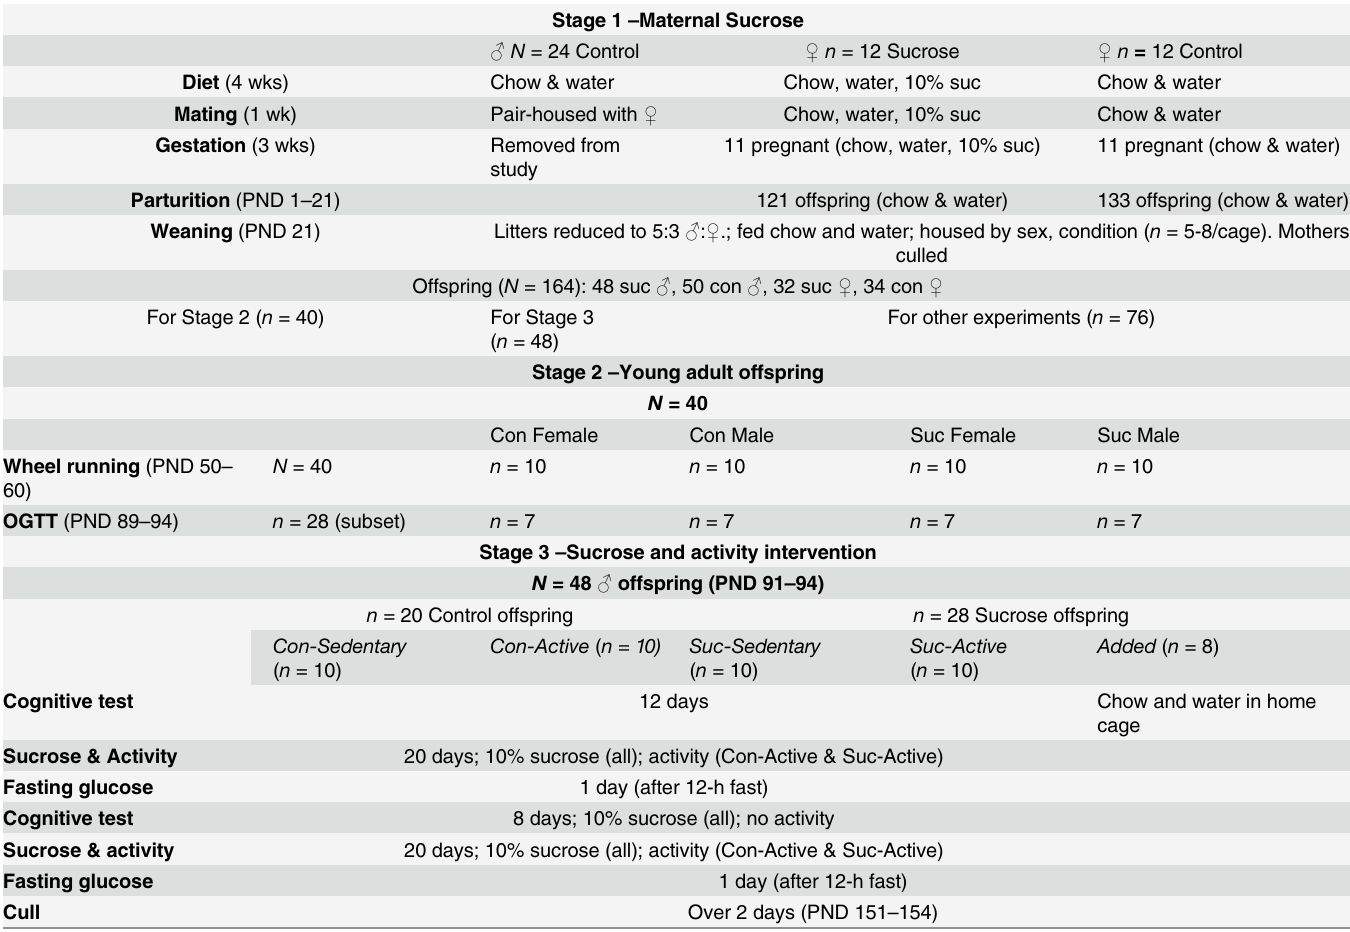
Table 1. Timeline of experimental procedures.